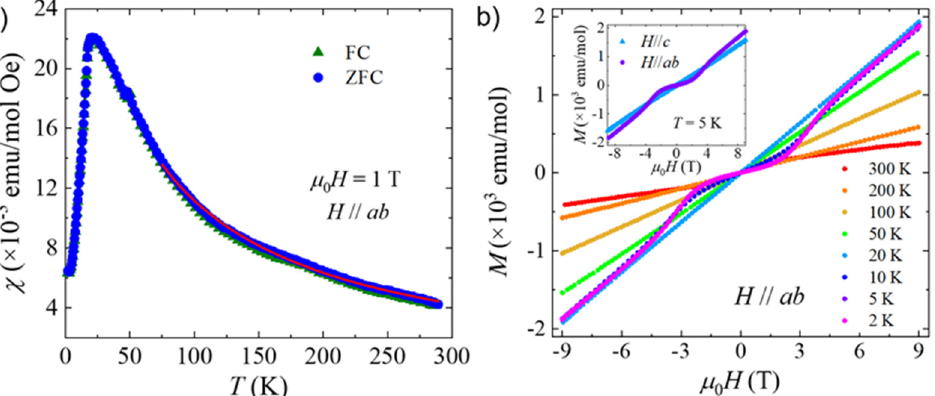
Figure 4. ( a ) Temperature dependence of dc magnetic susceptibility of selected KCrP 2 S 7 crystals measured in a field of 1 T employed parallel to the ab plane ( H // ab ). The red solid lines indicate the fit to the modified Curie-Weiss law. ( b ) Field dependence of isothermal magnetization (M) of KCrP 2 S 7 at different temperatures, measured under H // ab . Inset: isothermal magnetization at 5 K with both in-plane ( H // ab ) and out-of-plane magnetic fields.